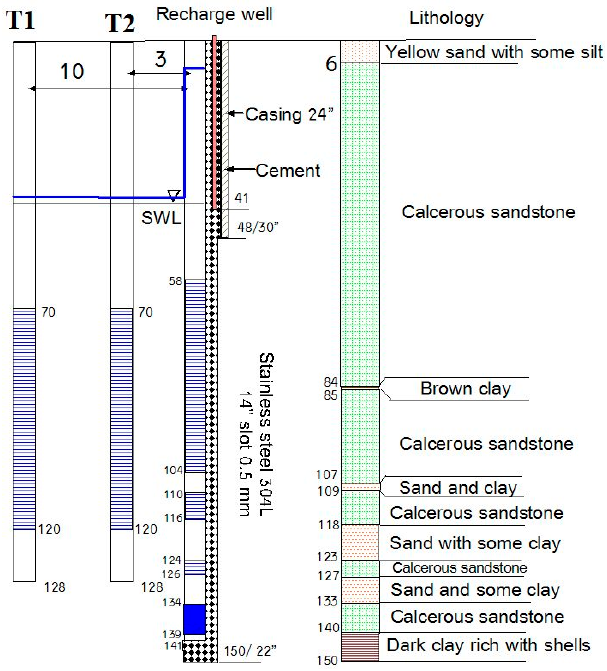
Figure 9. A schematic cross section showing the water level (thick blue line) at the end of the injection test in the recharge well and in the observation well.